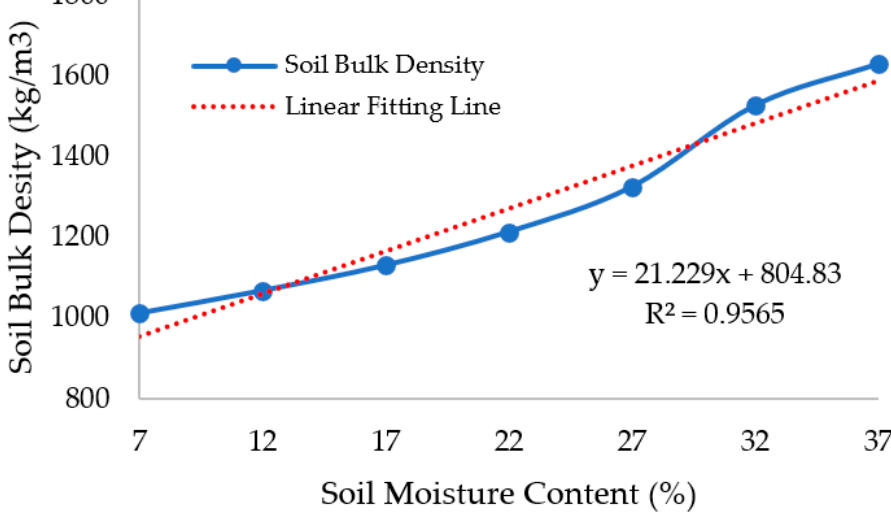
Figure 18. The soil bulk density of different moisture contents.